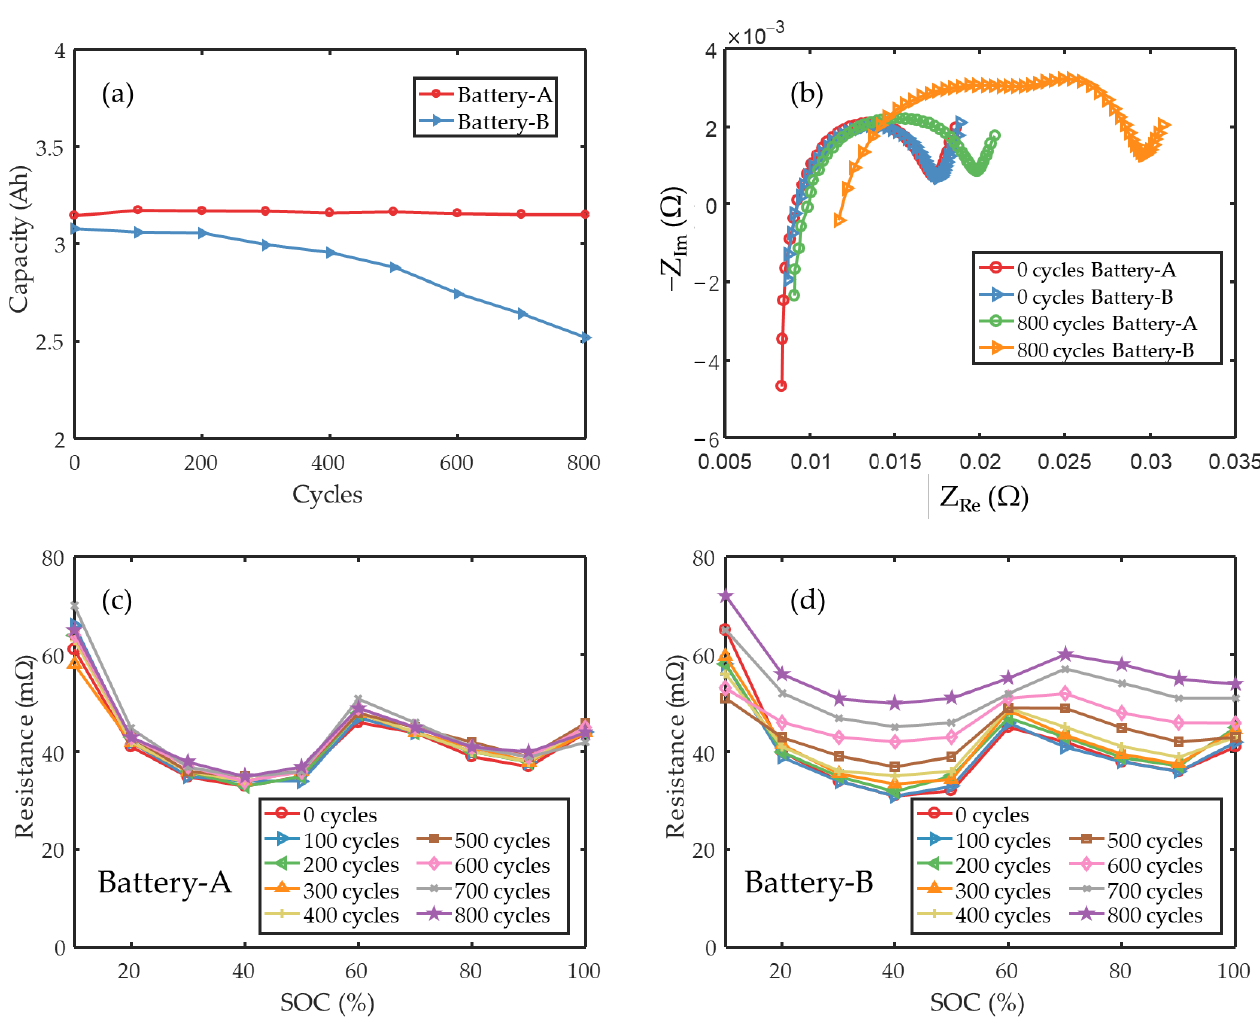
Figure 10. The evolution of ( a ) the discharge capacity, ( b ) the EIS at 50% SOC, ( c , d ) the direct current discharge resistance at 50% SOC.